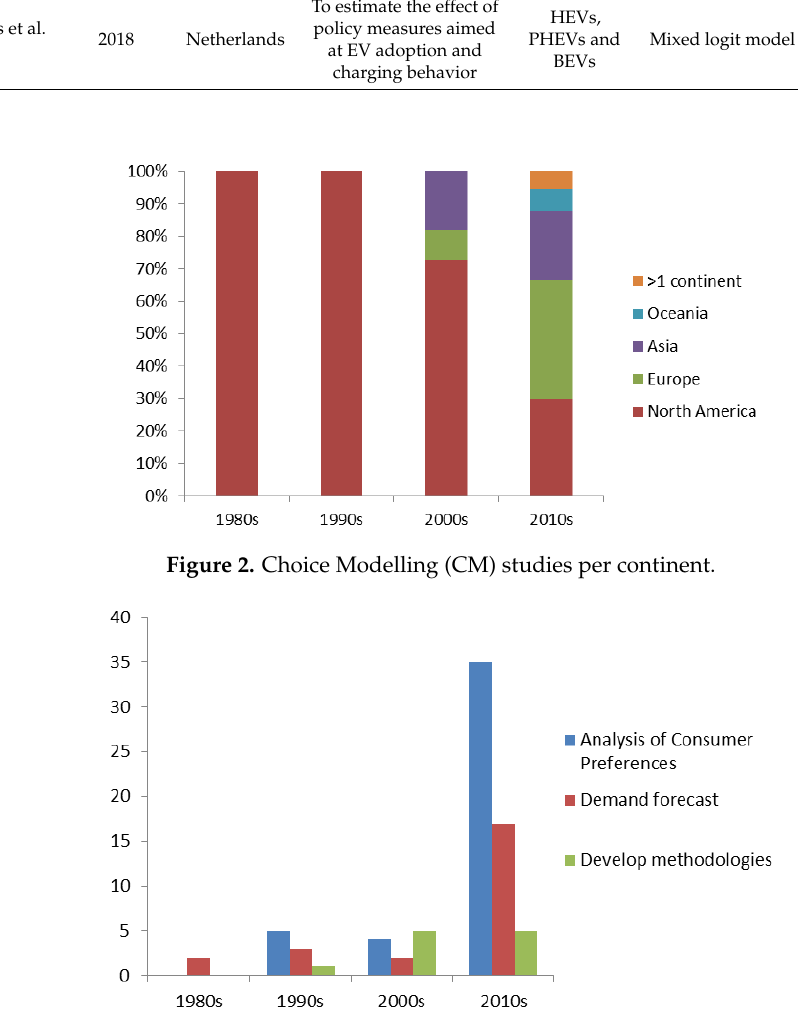
Figure 3. Goals of CM studies evolving with time.